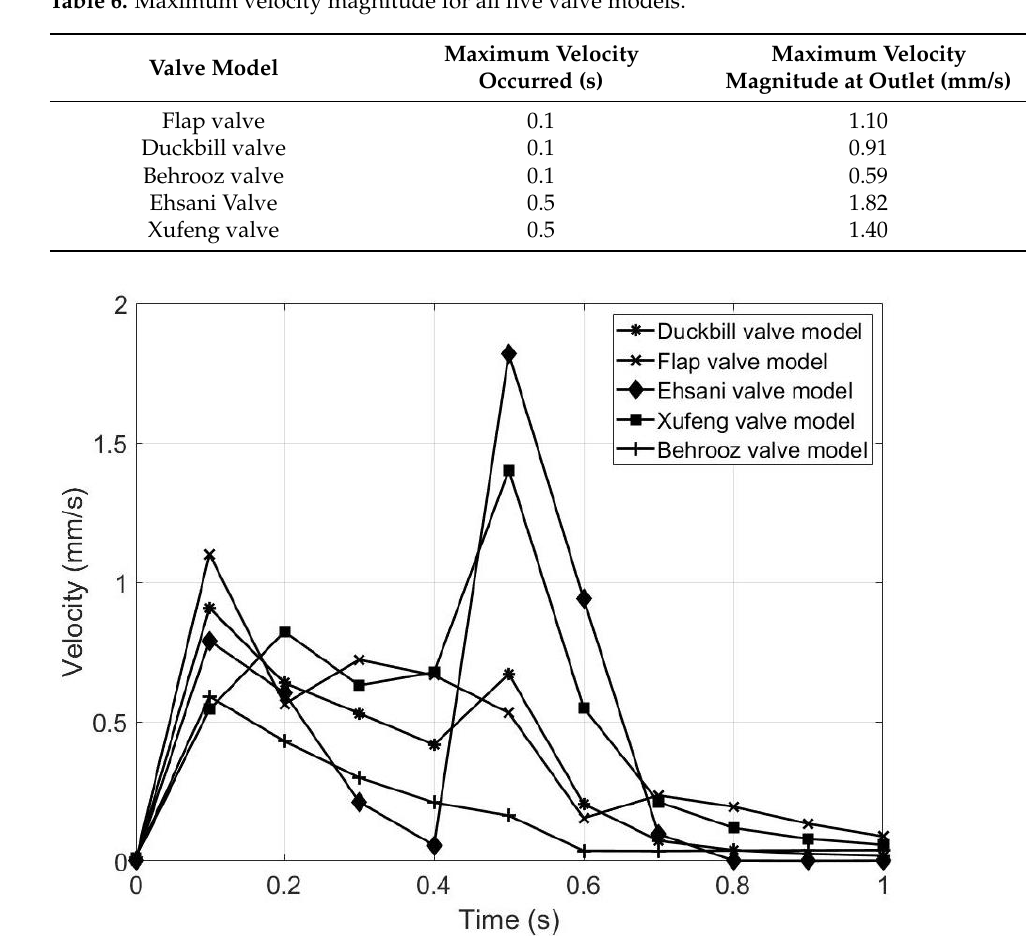
Table 6. Maximum velocity magnitude for all five valve models.